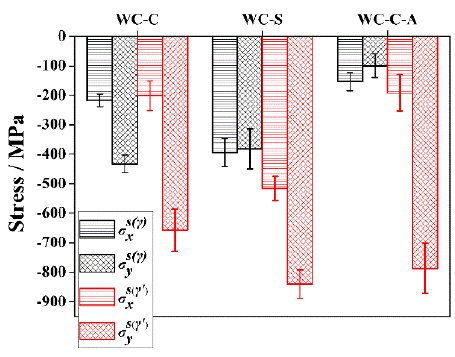
Figure 7. The stress of the γ / γ ′ phase in the σ xs and σ ys directions for samples WC-C, WC-S, and WC-C-A.